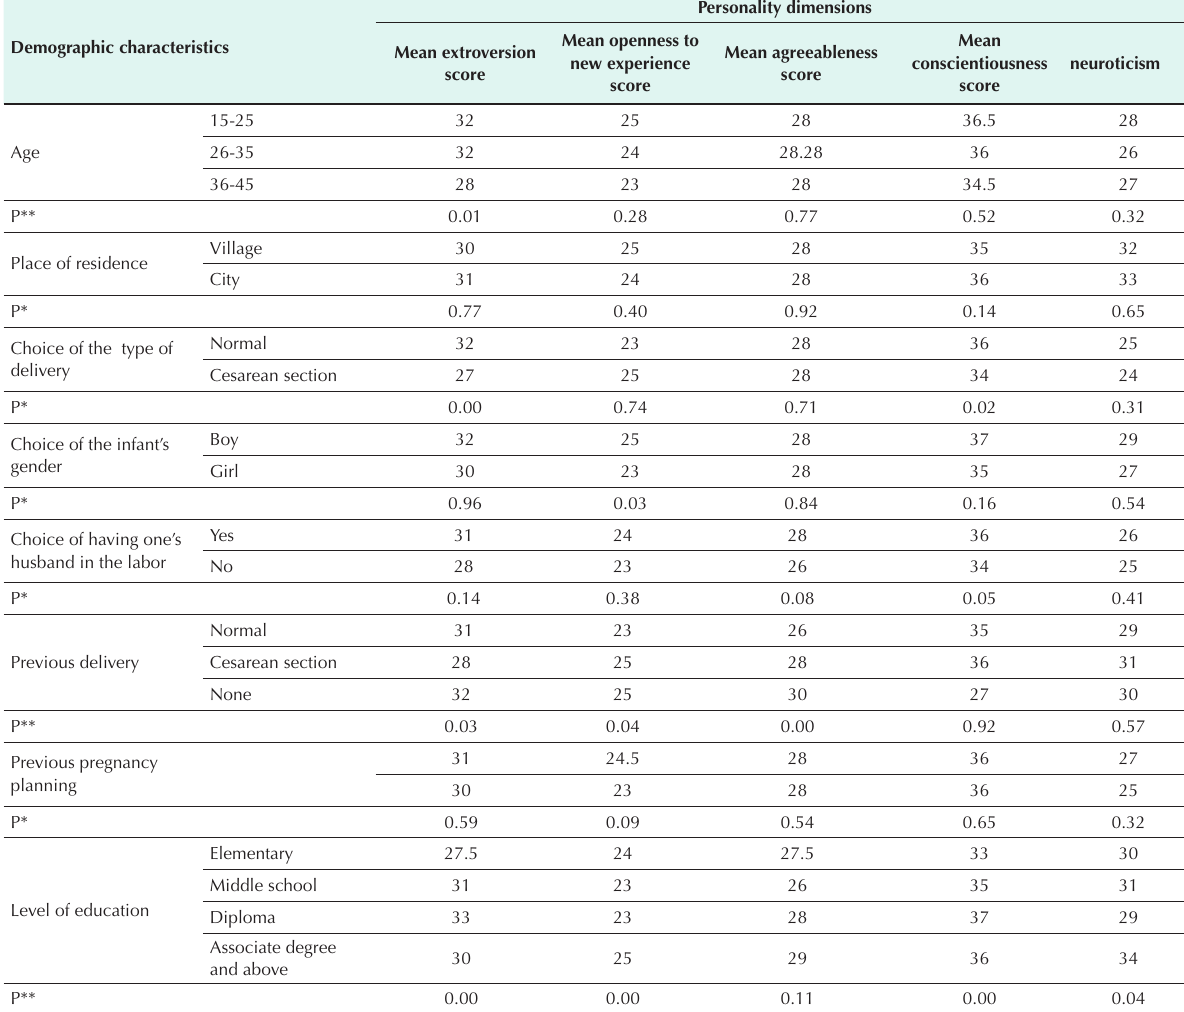
Table 2. Comparison of the Mean and Range of Changes in Personality Dimensions in Terms of Demographic Variables